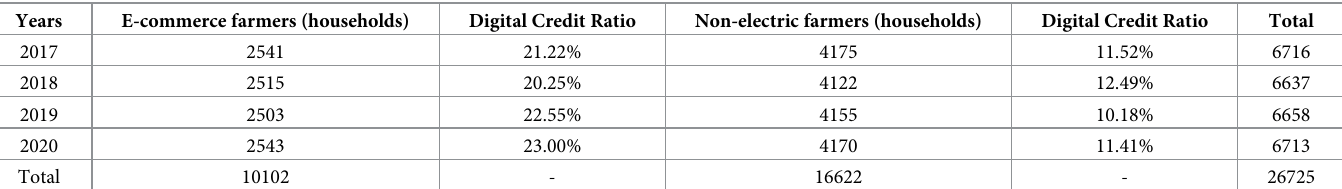
Table 1. Distribution of sample